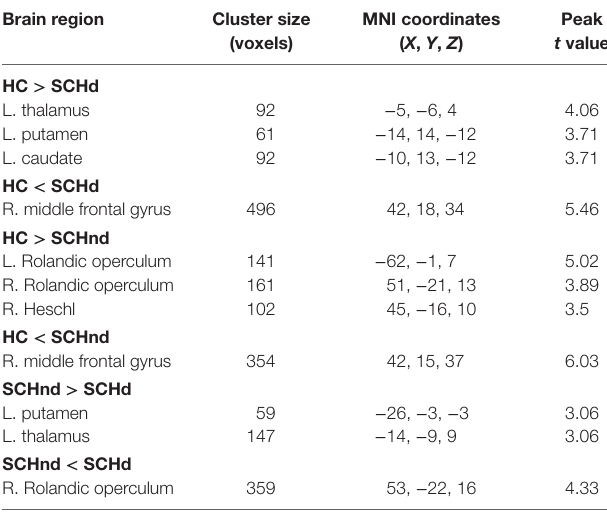
TaBle 2 | Inter-group differences of gray matter volume ( p < 0.05, FDR corrected). Brain region